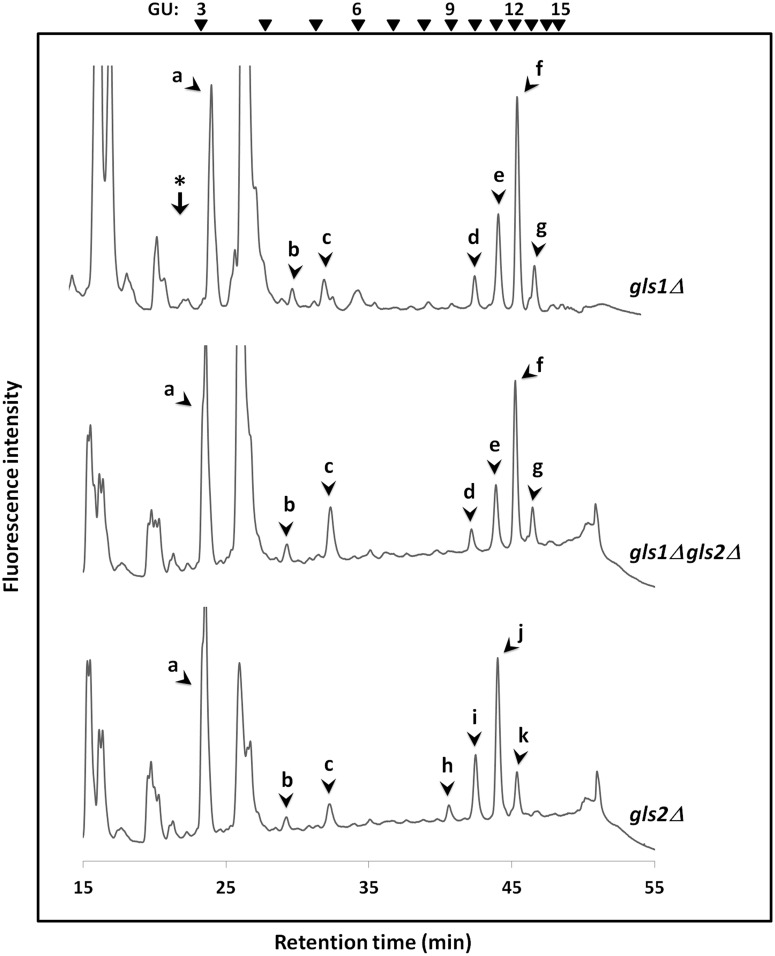
Size-fractionation HPLC profiles of PA-labeled FNGs derived from the glucosidase mutant cells in log phase.Peaks 'a-c' which were observed in all the three glucosidase mutants, are not likely to be FNGs. Peaks 'd-g' produced in gls1Δ and gls1Δ gls2Δ cells, correspond to Glc3Man6-9GlcNAc2-FNGs, whereas 'h-k' from gls2Δ cells correspond to Glc2Man6-9GlcNAc2-FNGs. The arrowheads indicate the elution position of PA-glucose oligomer for elution standards. The arrow with the asterisk shows the elution position of Man1GlcNAc2.